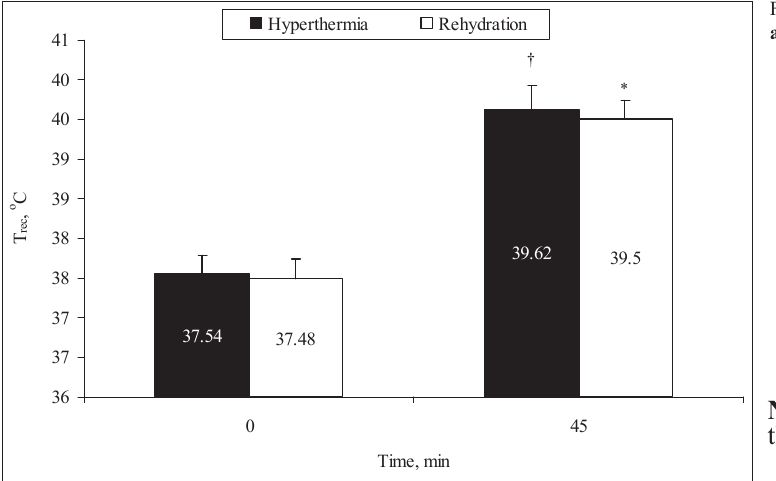
Fig. 1. Indices of rectal temperature before and after passive warming